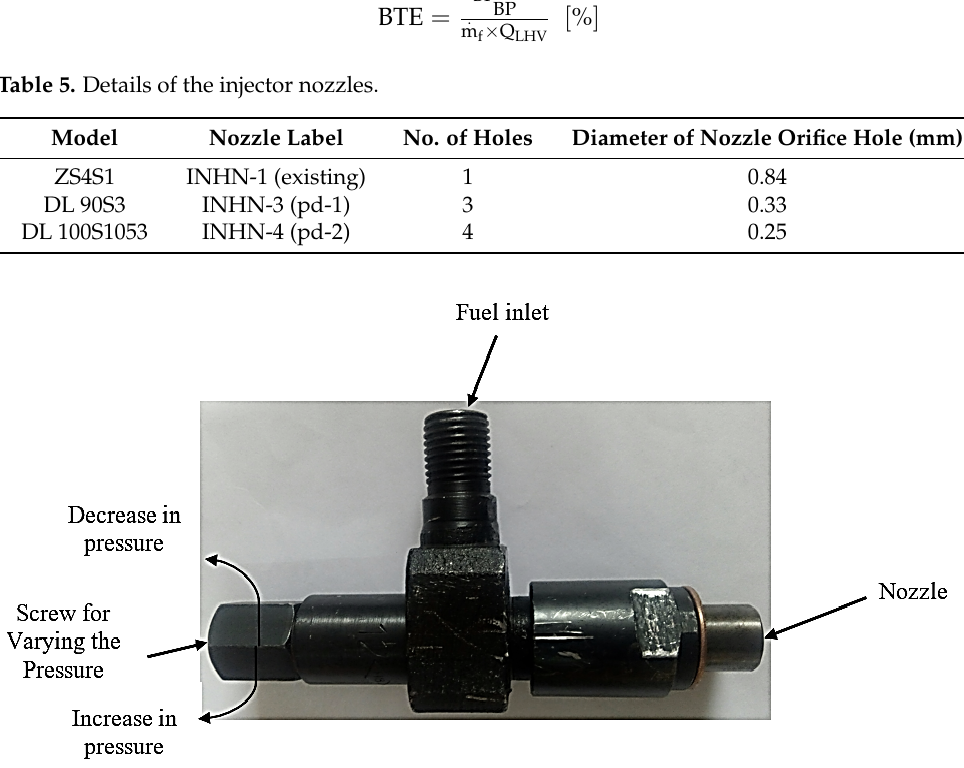
Figure 9. Different injector nozzles photograph. 3.3. Experimental Test Matrix The number of tests that were executed and guidance for experimental work is an experimental test matrix. The baseline and detailed experimental test matrices are listed below. From the experimental investigation observations, the superior combined com- binations of the injector nozzles operating at optimal load conditions, INHNs and fuel IPs with better brake thermal efficiency, fuel economy, and reduced exhaust emission are obtained. Table 6. The test matrix for the experimental analysis. Operating and Design Conditions Experiment